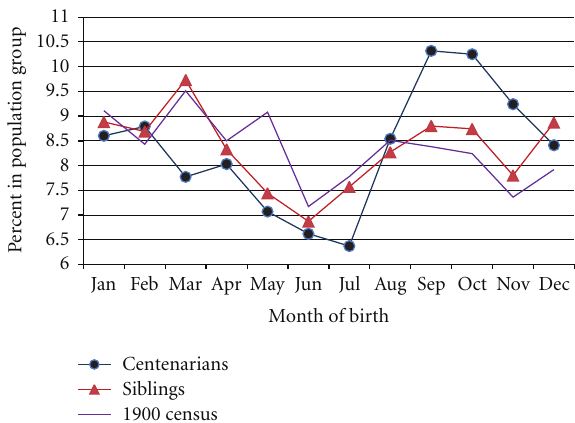
Figure 1: Distribution of individuals by month of birth in percent: centenarians, their shorter-lived siblings survived to age 20 and the USA population born in 1880–1895 according to the 1900 US Census.